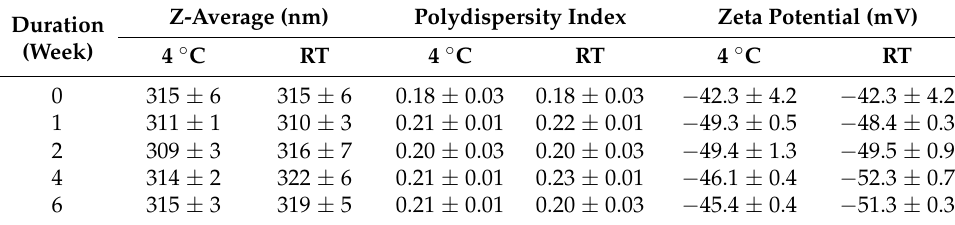
Table 1. Stabilization of NanoA suspension storing at 4 ◦ C or room temperature (RT) over six